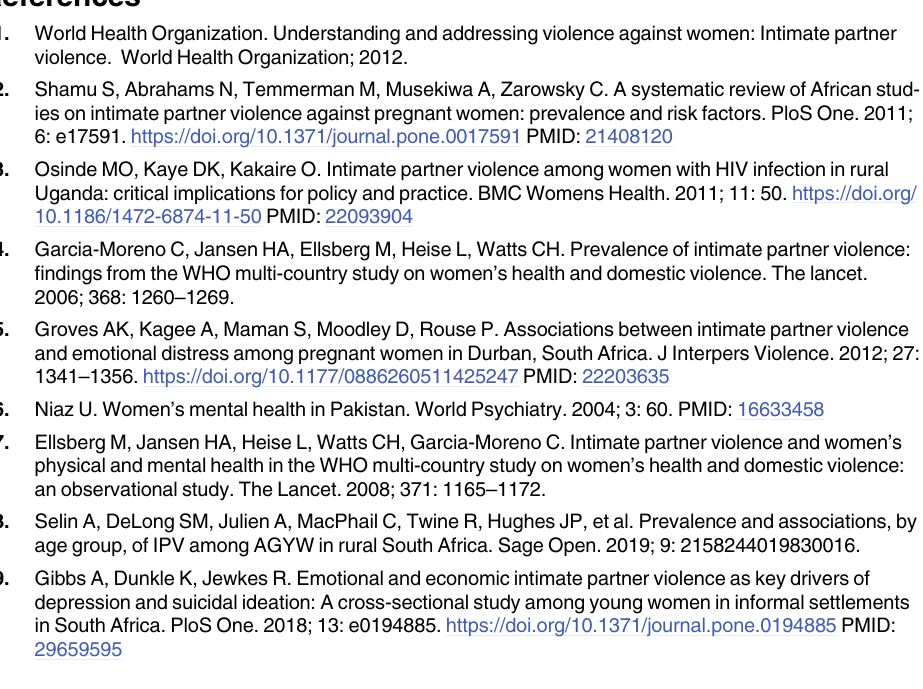
S6 Table. Pearson Chi-square test of IPSV by selected characteristics of urban women in